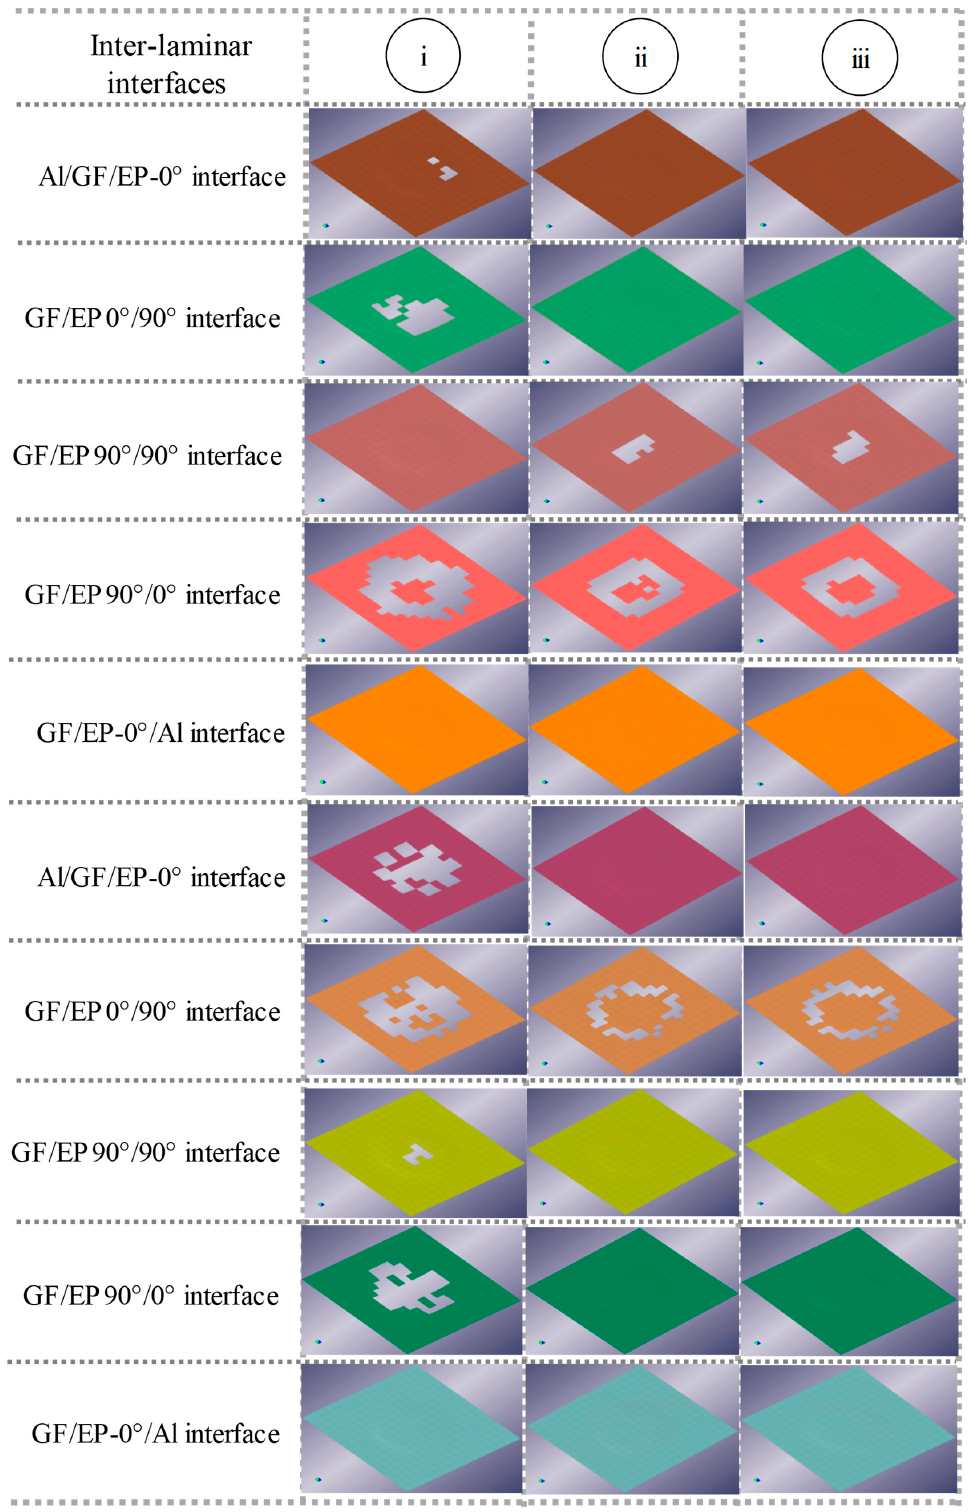
Figure 9. Debonding and delamination of cohesive interfaces of the GLARE laminate ( i ) at room temperature, ( ii ) at 80 °C (39% tougher epoxy-FM94), and ( iii ) at 80 °C (45% tougher epoxy-FM94) at 0.12 ms; the cohesive interfaces are organized from the impacted (top) to the non-impacted (bottom) side.